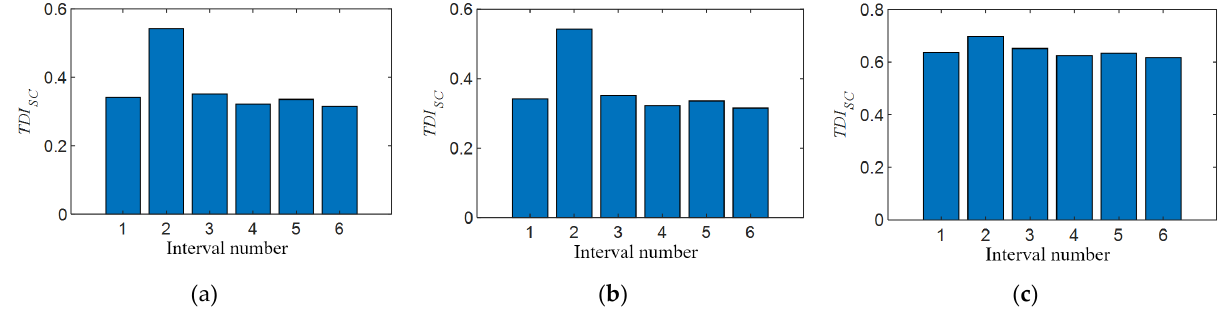
Figure 20. TDI SC validation at different vehicle speeds: ( a ) TDI SC of stiffness damage in the second interval when vehicle speed is 0.251 m/s; ( b ) TDI SC of stiffness damage in the second interval when vehicle speed is 0.503 m/s; and ( c ) TDI SC of stiffness damage in the second interval when vehicle speed is 0.741 m/s.